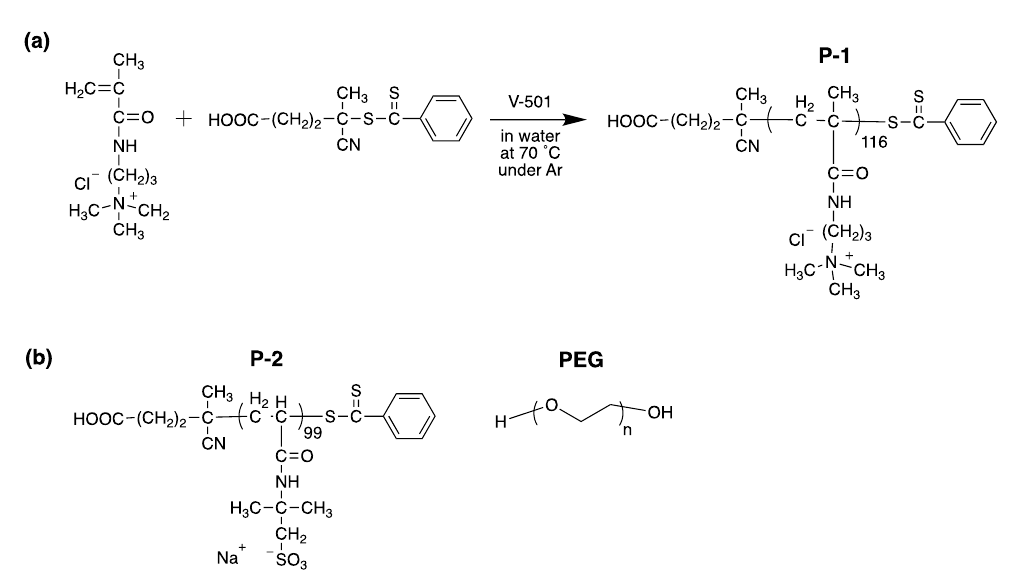
Figure 2. Synthesis scheme of ( a ) P-1 and ( b ) structures of P-2 and PEG.